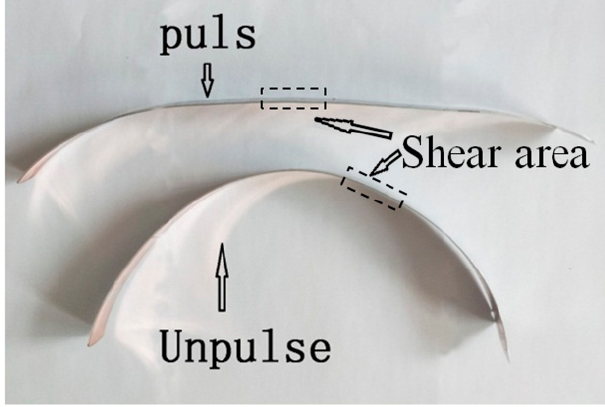
Figure 1. Shape of Cu/Al laminated composite after rolling.